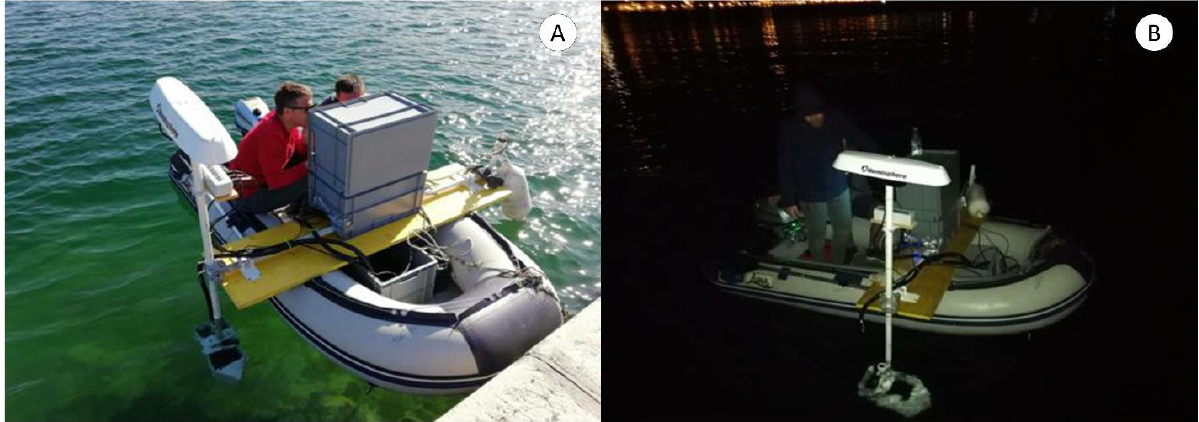
Figure 2. The small boat Luna at ( A ) the beginning and ( B ) the end of the MBES survey.